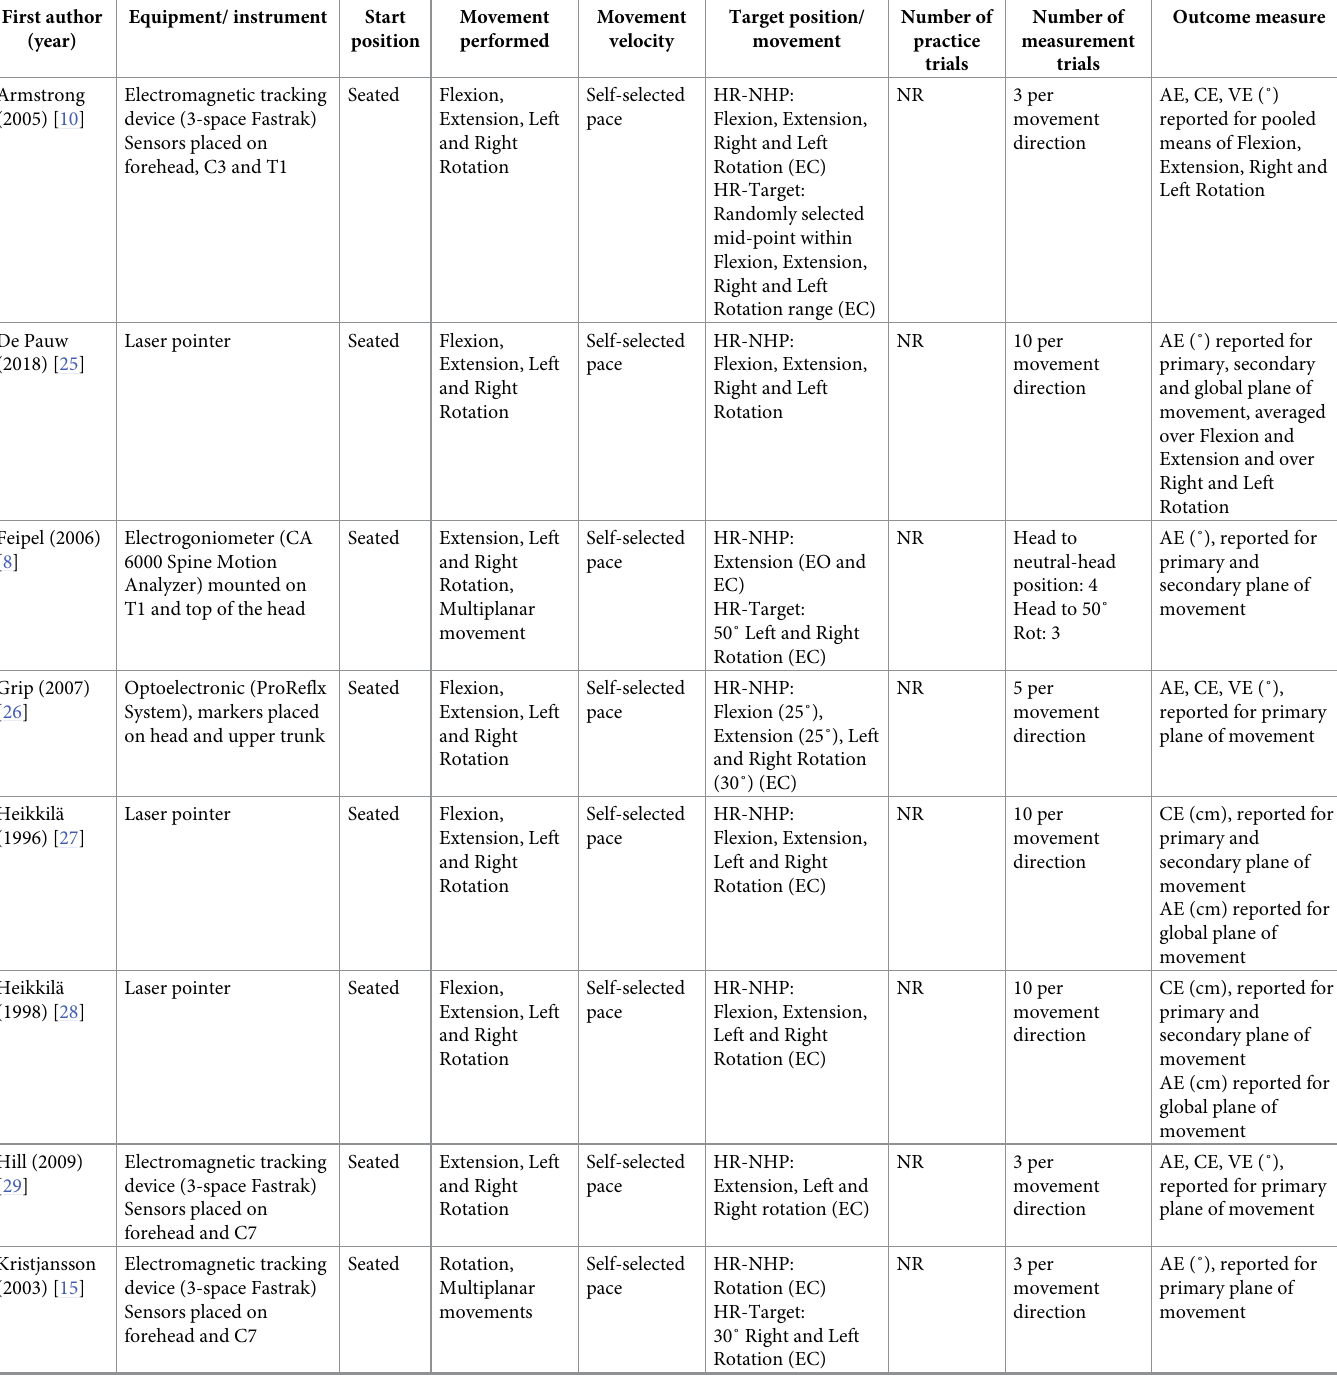
Table 4. Measurement protocol of studies measuring joint position sense